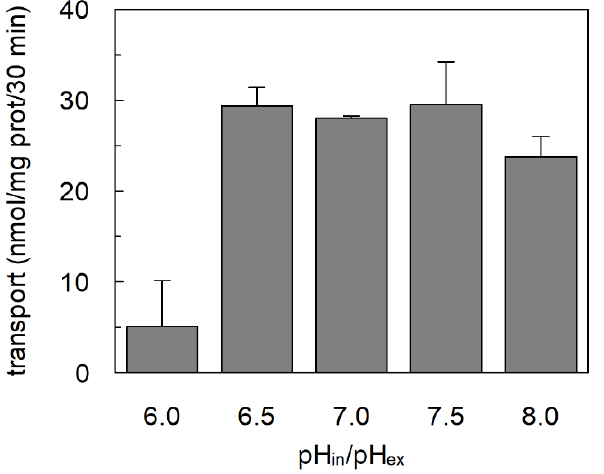
Figure 4. Effect of pH on [ 3 H]-glutamine unidirectional transport by C467A reconstituted in prote- oliposomes. The reconstitution was performed as described in Materials and Methods except that 20 mM HEPES Tris at the indicated pH was used. The transport was measured adding 500 µM [ 3 H]- glutamine prepared with 20 mM HEPES Tris at the indicated pH, and 50 mM external Na-gluconate. The transport was stopped after 30 min, according to the stop inhibitor method. Results are means ± S.D. from three independent